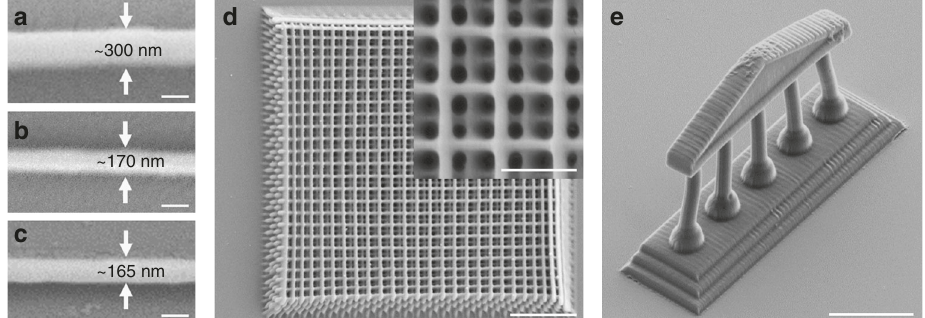
Fig. 2 SEM images of polymer lines and 3D structures written on a glass substrate. Polymer line composed of a 100 mol% ISEA, b 97.5 mol% ISEA and 2.5 mol% PETA, and c 100 mol% PETA (scale bars = 200 nm). d Woodpile structure composed of 97.5 mol% ISEA and 2.5 mol% PETA (scale bars = 1 and 4 μ m, respectively). e Fragment of a Greek temple with multiple columns holding up an entablature composed of 97.5 mol% ESEA and 2.5 mol% PETA